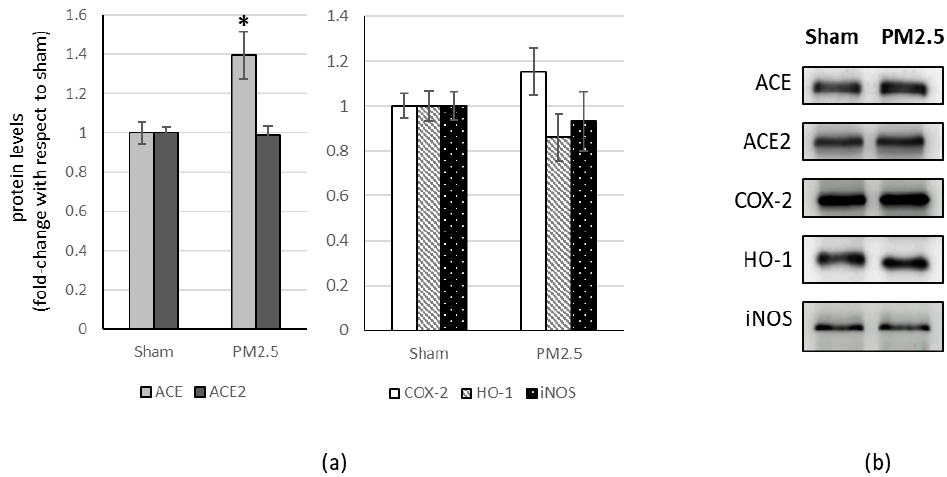
Figure 5. Immunoblotting analysis of ACE, ACE2, and COX-2, HO-1, iNOS in the brain. ( a ) Proteins were evaluated following cell subacute treatment with PM2.5. Each protein has been normalized with respect to the total amount of proteins detected by Ponceau staining, allowing a straightforward correction for lane-to-lane variation. Each protein has been normalized onto the respective sham (n = 5). Values represent Mean ± SE. * p < 0.05 versus sham ( b ) Corresponding representative immuno-blotting